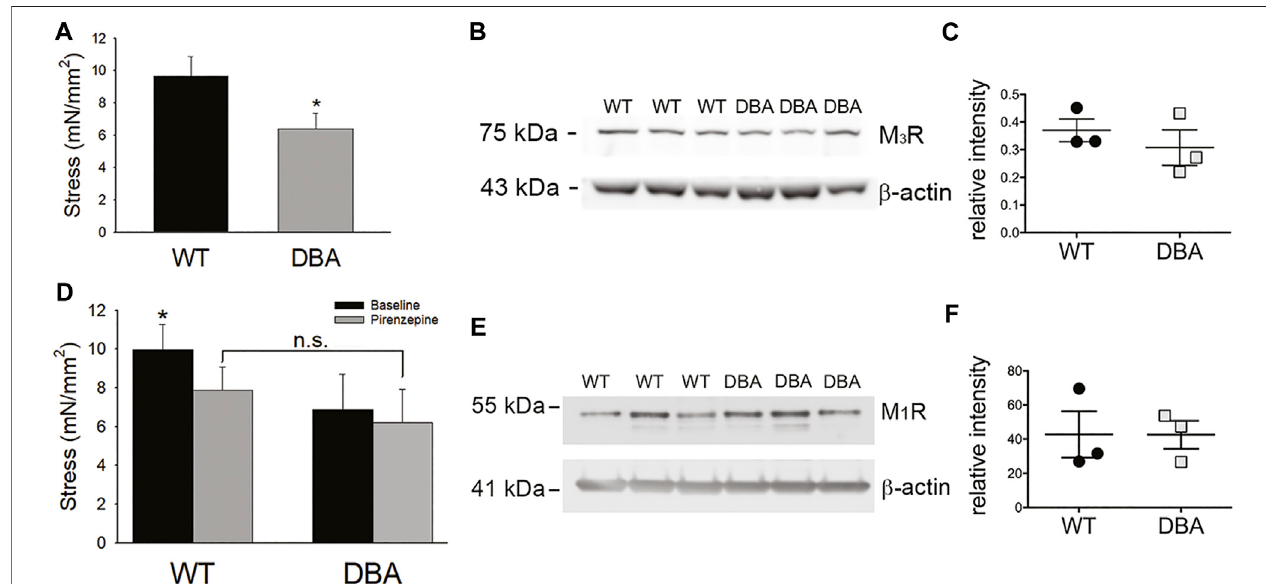
FIGURE 11 | Cholinergic responses of WT and DBA bladders. (A) Contractile responses of DBA (gray bar) bladder smooth muscle to the muscarinic receptor agonistCCh,wassigni fi cantlylowerthanWT(blackbar)responses( N =11WT, N =13DBA,* p =0.041). (B) WesternblotcomparingexpressionofM 3 RinWTandDBA bladder smooth muscle extracts, relative to β -actin loading control. The molecular weight in kDa of mass standards are shown by the tick marks. (C) Quantitative data indicate that muscarinic M 3 R expression in WT (black circles) and DBA (gray squares) detrusors was not signi fi cantly different ( N = 3, p = 0.8). (D) Contractile responses induced by CCh in WT and DBA detrusors were generated before (black bars) and after (gray bars) inhibition of the M 1 R inhibitor with pirenzepine. In WT detrusors, CCh-evoked contractions were signi fi cantly inhibited by pirenzepine ( N = 7; * p = 0.008), while contractions in DBA detrusors were not affected ( N = 5, p = 0.31). In the presence of pirenzepine, the contractile response to CCh in WT was not different from DBA ( p = 0.25). (E) Western blot comparing the expression of the facilitatory muscarinic receptor, M 1 R, in three WT and three DBA bladder muscularis extracts. Molecular weight in kDa of mass standards is indicated at tick marks. (F)